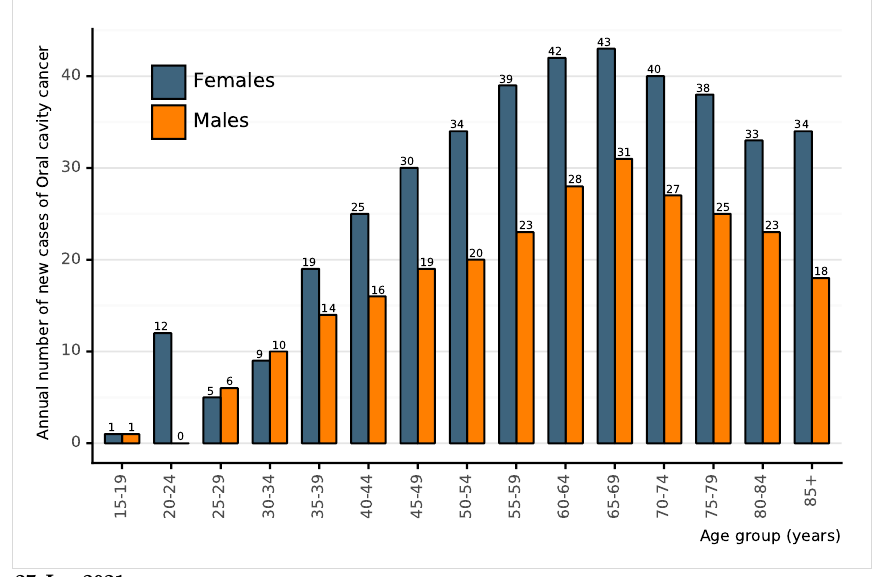
Figure 43: Annual number of new cases of oral cavity cancer in Peru (estimates for